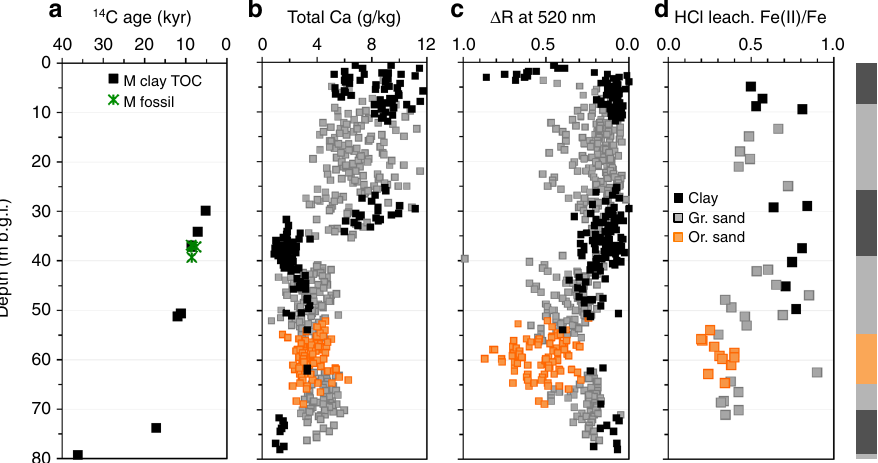
Fig. 2 Site sediment vertical pro fi les. a Conventional radiocarbon ( 14 C) ages expressed in thousands of years (kyr) measured on fossil plant material embedded in the sediment and/or total organic carbon of the clay layers. b Total calcium (Ca) content determined by X-ray fl uorescence. c Diffuse spectral re fl ectance between 530 and 520 nm ( Δ R). d Percentage of Fe(II) within the total Fe extractable by 1 N hot HCl. Sand color, quanti fi ed by Δ R and dictated by Fe speciation, is explicitly displayed to visualize orange and gray sand distribution. Results from the four multi-level well nest boreholes and the additional coring location are combined in the graphics and were used to prepare the generic site lithology displayed on the